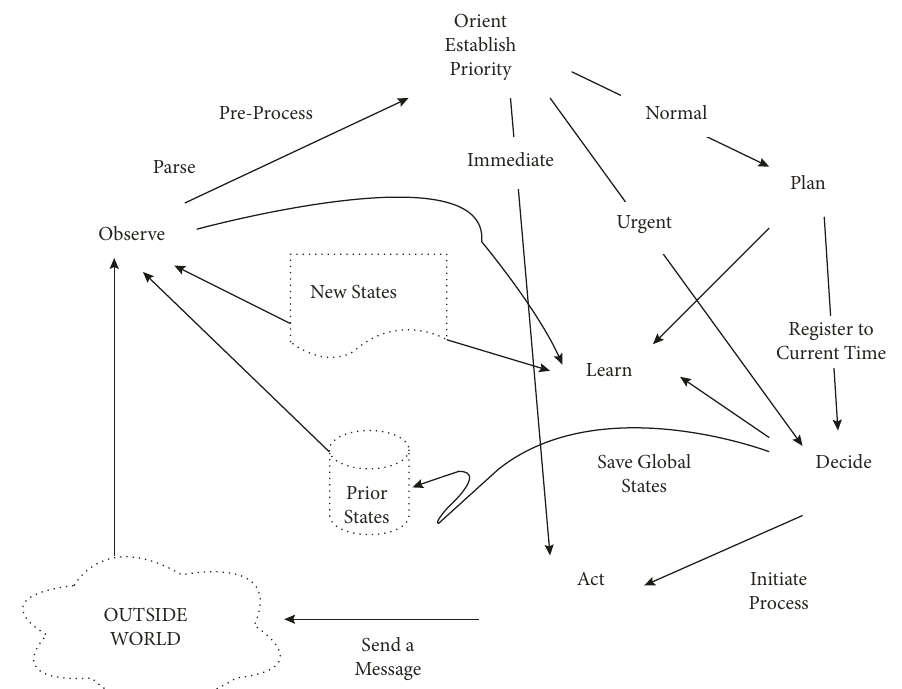
Figure 12: Actions of cognitive